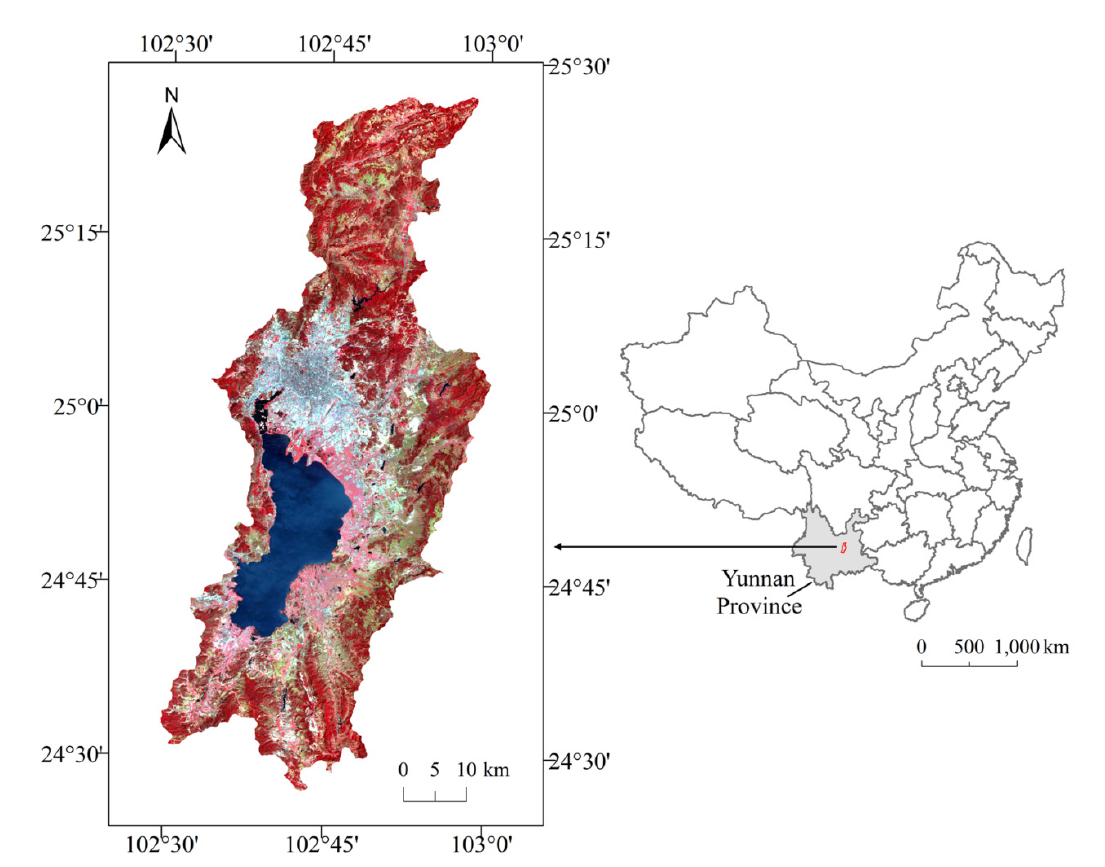
Figure 1. The Dianchi watershed and its